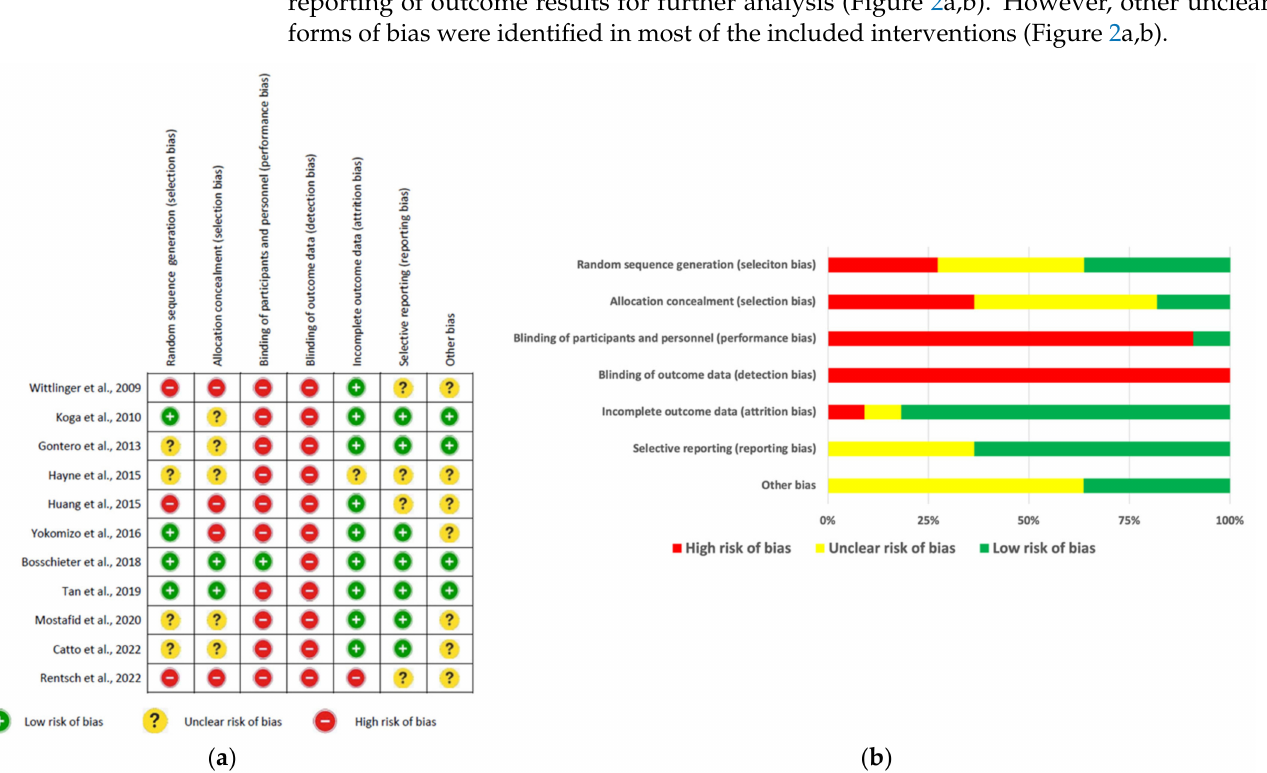
Figure 2. Summary of risk of bias results evaluated by using the CONSORT 2010 checklist for interventional studies: ( a ) The risk of bias levels of key RCT components rated in every included study; ( b ) the percentage of each risk of bias level of the key components